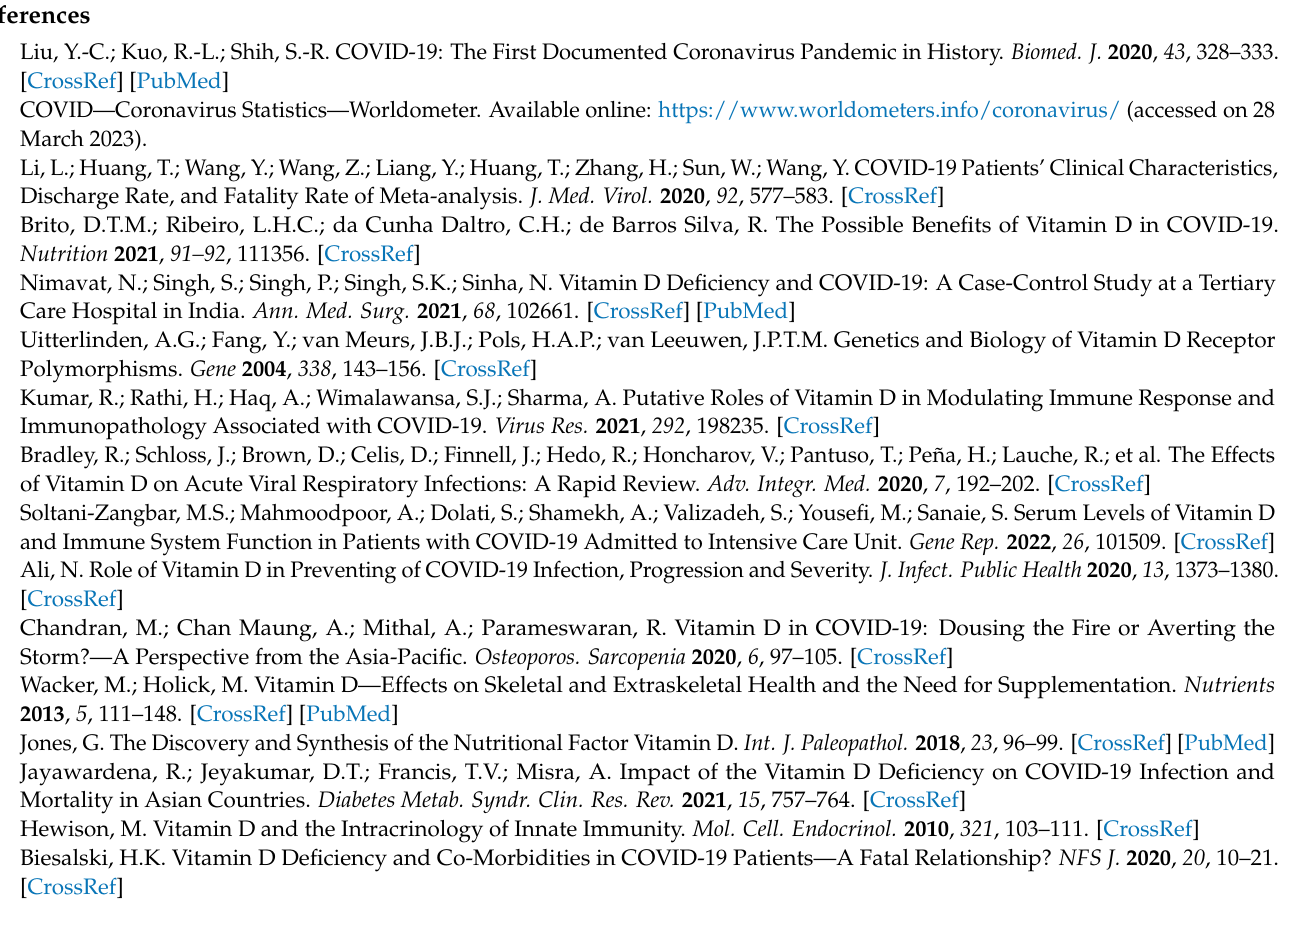
Figure S1: Plasma 25(OH)D levels in blood samples of COVID-19-positive and COVID-19-negative participants separated by age; Figure S2: Plasma 25(OH)D levels in blood samples of COVID-19- positive and COVID-19-negative participants separated by sex; Figure S3: Plasma 25(OH)D levels in COVID-19-positive subjects’ blood samples and rs2228570 alleles; Figure S4: Plasma 25(OH)D levels in COVID-19-negative subjects’ blood samples and rs2228570 alleles; ns = not